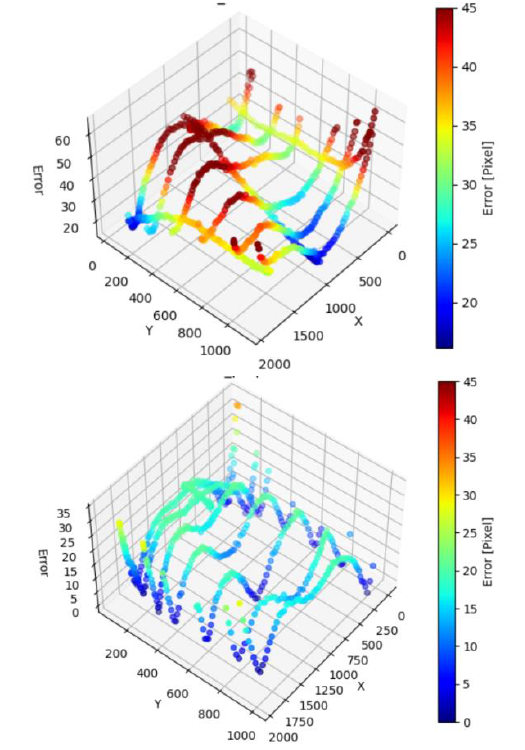
Figure 11. Visualizing the overlay error in relation to the position. Top is uncalibrated and the bottom one represents a perspective transformation. The heat map is scaled the same in both